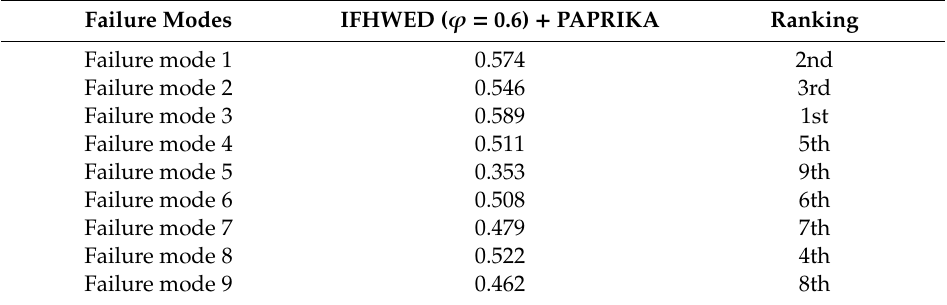
Table 12. Ranking of failure modes using IFHWED and subjective weights in risk criteria using PAPRIKA.